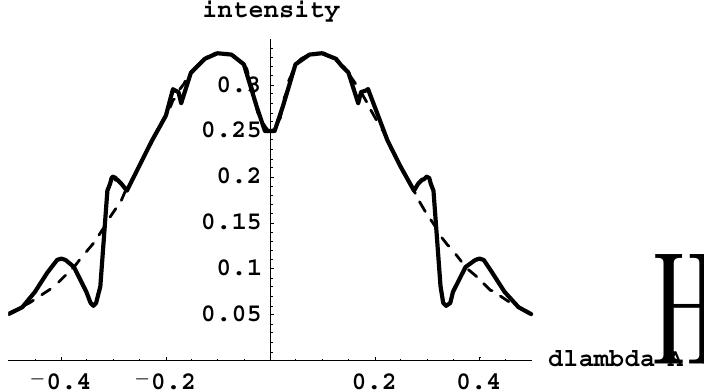
Figure 15. Theoretical profile of the Ly-delta line of deuterium, calculated with the allowance for all broadening mechanisms and for the effect of strong Langmuir waves, at the following parameters: N e = 10 15 cm − 3 , N b = 6 × 10 9 cm − 3 , γ = 2 1/2 (corresponding to the beam kinetic energy of 210 keV), and T e = 2 eV. The solid curve corresponds to the presence of the strong Langmuir waves of E 0 = 20 kV/cm caused by a REB, while the dashed curve corresponds to the absence of the REB. The detuning ∆ λ (denoted “dlambda”) is in Angstrom [82].